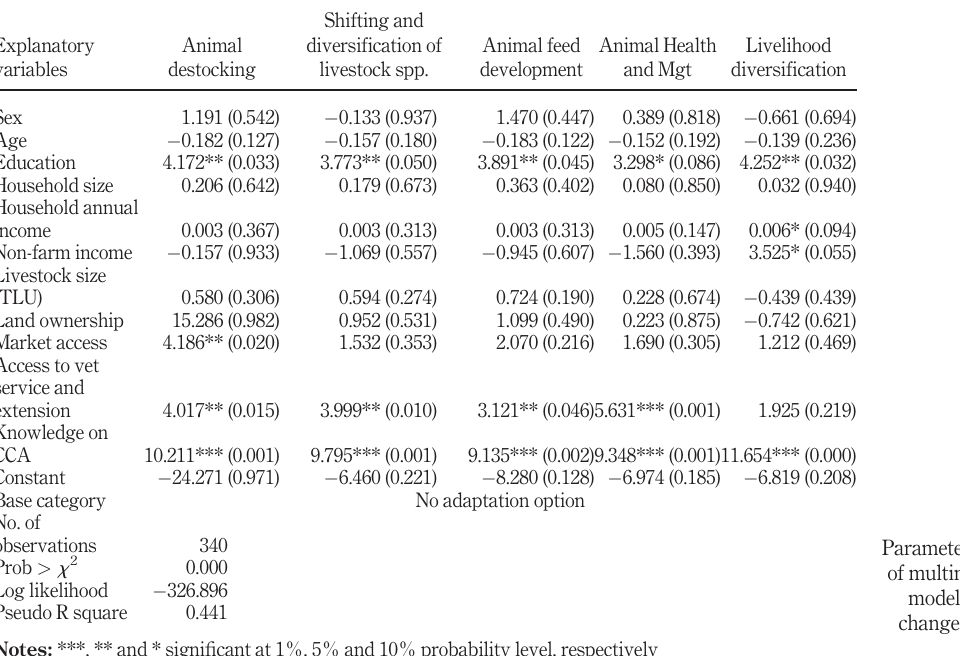
Table 1. Parameter